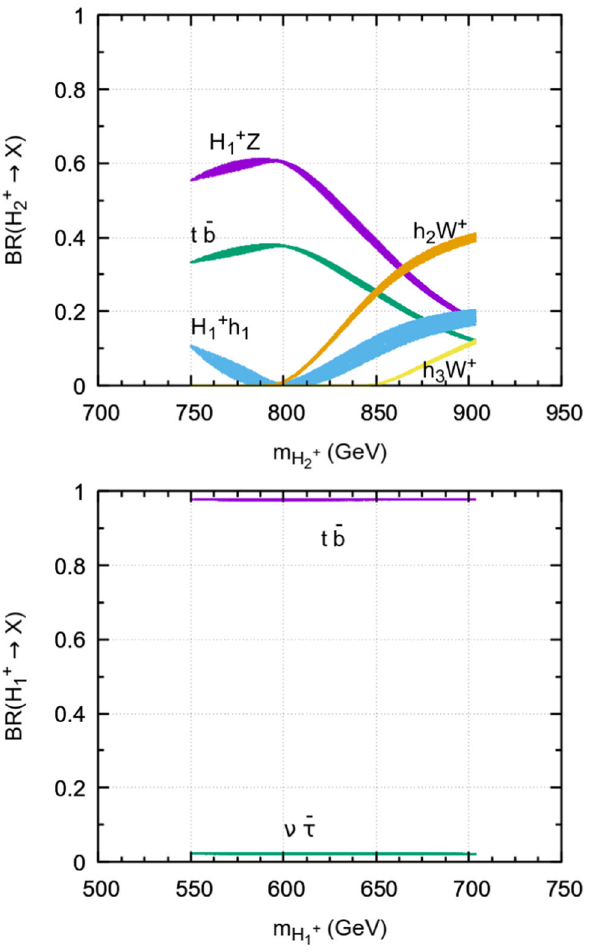
(upper panel) and H + (lower panel) 2 1 Fig. 11 Dominant BR’s for H + for benchmark point P 2 versus the charged Higgs masses